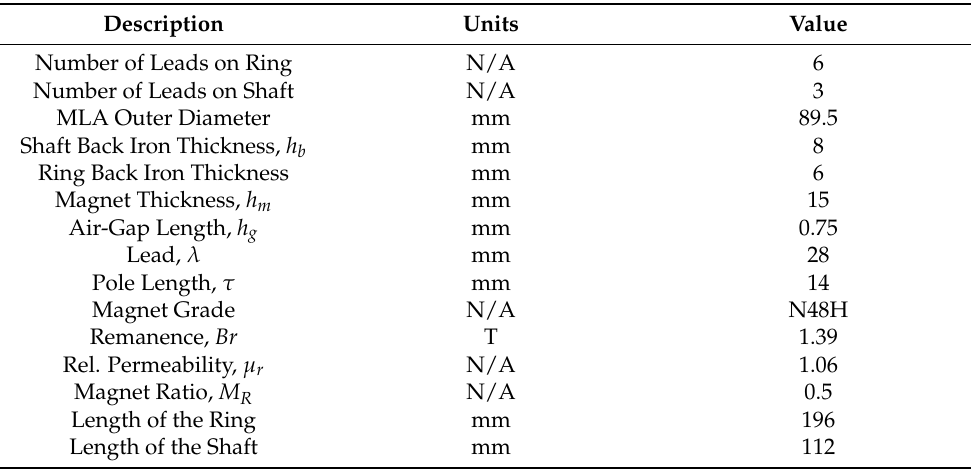
Table 3. Input Design Parameters